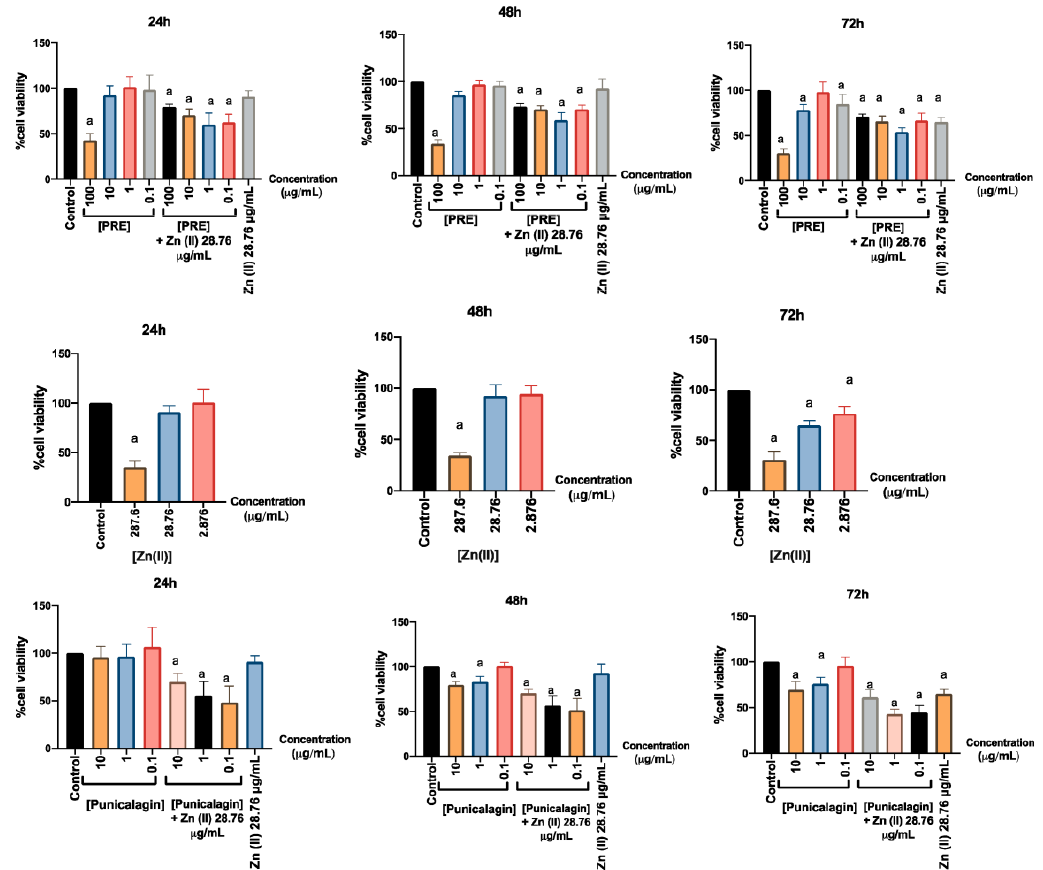
Figure 3. E ff ects of PRE (0.1–100 µ g / mL), punicalagin (0.1–10 µ g / mL) and 28.76 µ g / mL (0.1 mM) Zn (II) alone and in combination with Zn (II), on human gingival fibroblast viability and proliferation at 24, 48 and 72 h, as determined by MTT assay. Values are presented as the mean % ± SEM ( n = 3). Mean values with an “a” letter was significantly di ff erent than the untreated negative controls ( p < 0.001).